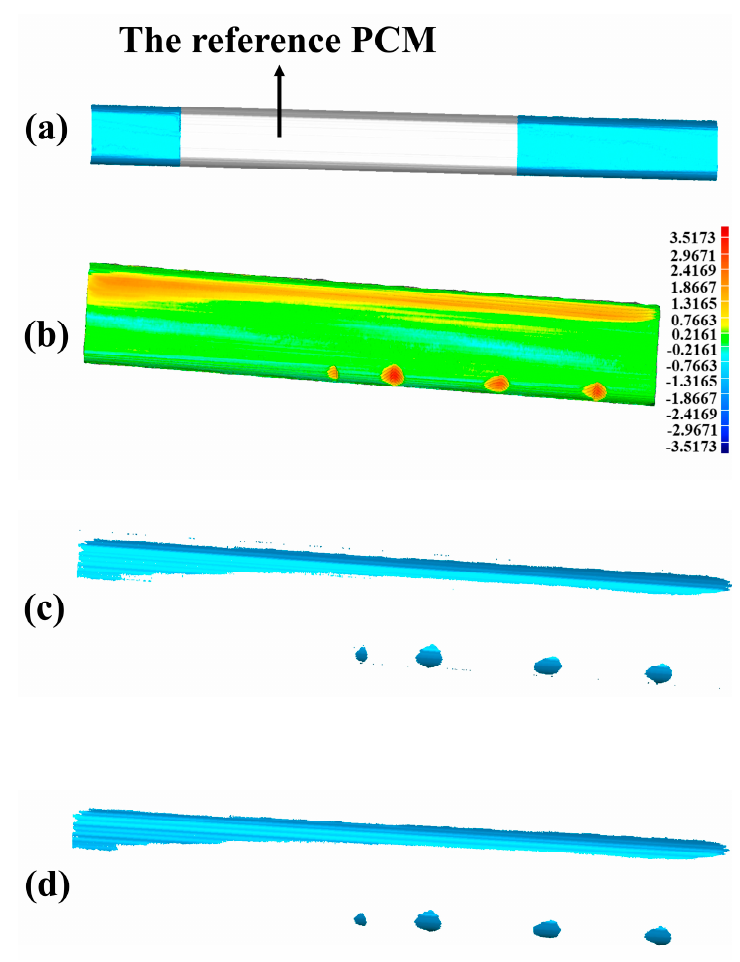
Figure 16. The acquisition of the scratch-data PCM. ( a ) The result of constructed reference PCM; ( b ) The depth-difference between the reference PCM and the scratch-surface PCM; ( c ) The original scratch-data PCM with noise points; ( d ) The filtered scratch-data PCM.